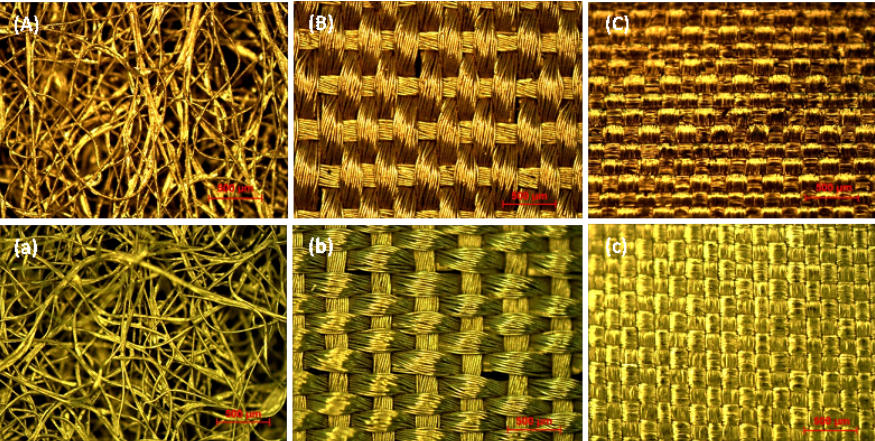
Figure 1. Micrograph images of copper-plated textiles NL-VL-S-016 ( A ), NL-WE-S-056 ( B ) and NL-WE-S-045 ( C ) and the corresponding textiles with Ni plating in ( a – c